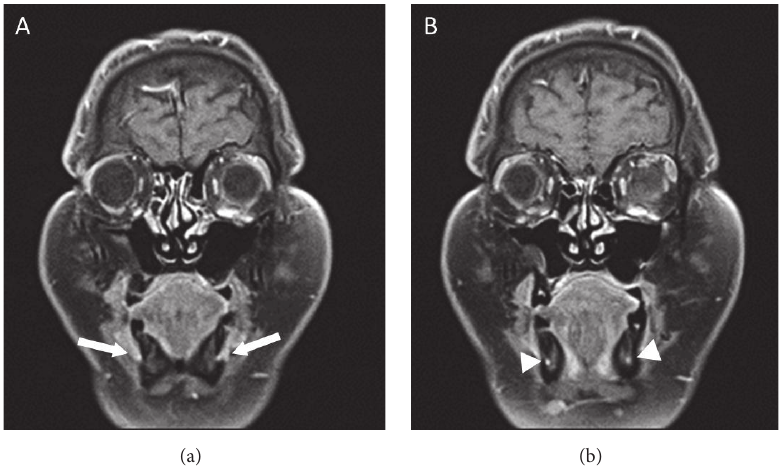
Figure 5: Serial coronal contrast-enhanced T1-weighted images of the face showing perineural infiltration with thickening and enhancement of the mental nerves bilaterally (arrows) with involvement of the inferior alveolar nerves as well